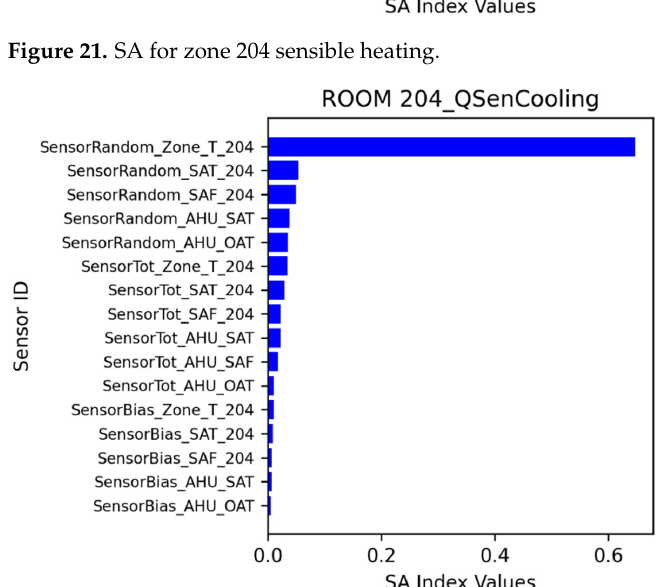
Figure 22. SA for zone 204 sensible cooling.